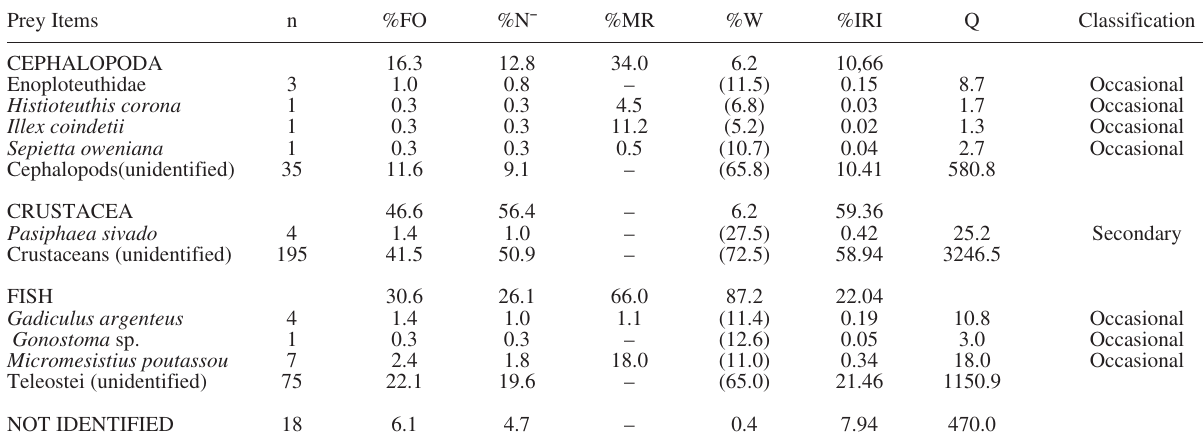
Table 3. – List of identified prey categories in the diet of Etmopterus pusillus caught by trawling (number of individuals with food in their stomachs=295). GE: ecological group (D: demersal, M: mesopelagic, P: pelagic, B: benthic, Na: not attributable); n: number of prey; %FO: frequency of occurrence; %N: percentage in number; %MR: percentage by reconstructed mass %W: percentage by dry weight (estimated mass within each component is in parentheses); %IRI: index of relative importance; Q: food coefficient; and prey classification. Prey Items